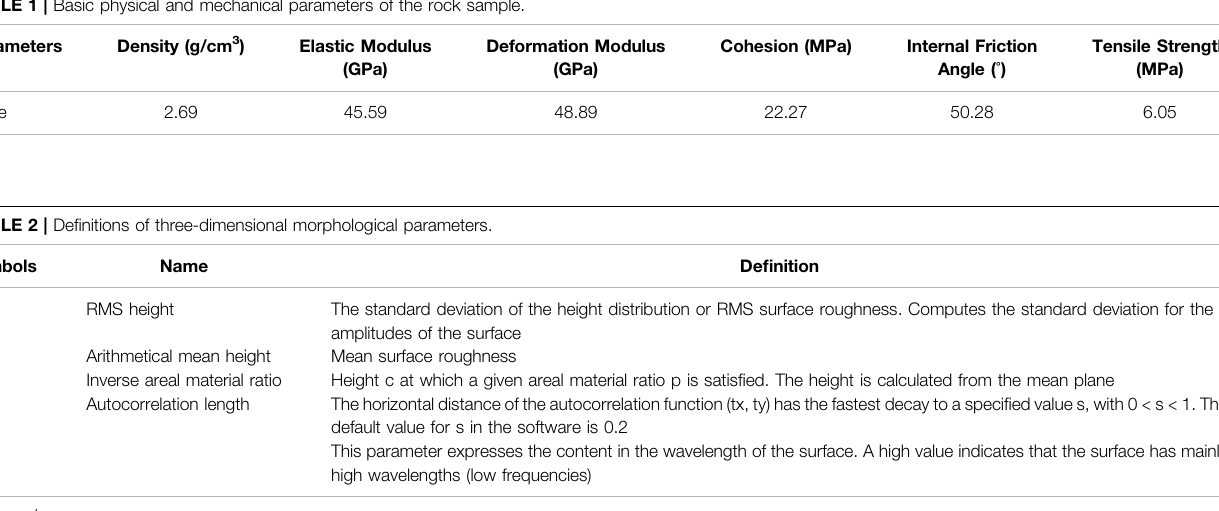
Frontiers in Physics |